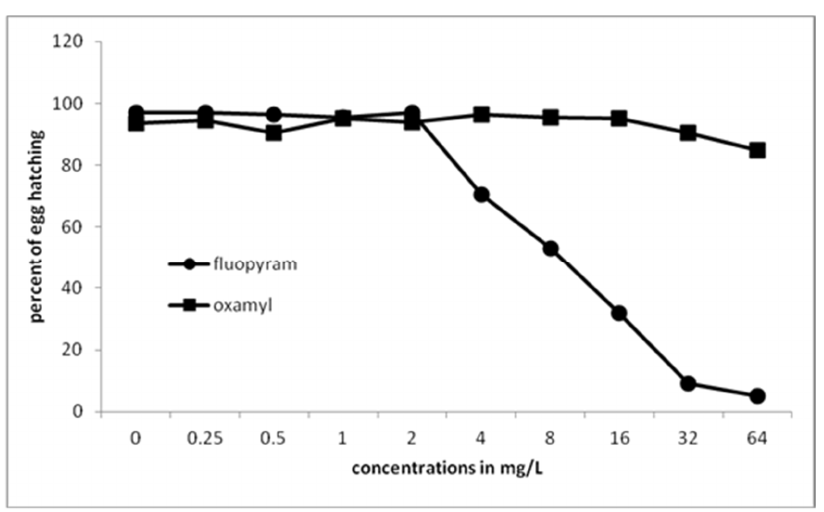
Figure 3. Effect of fluopyram or oxamyl on hatching after immersion of eggs at different concentrations for 30 days. Values are means of five replicates.